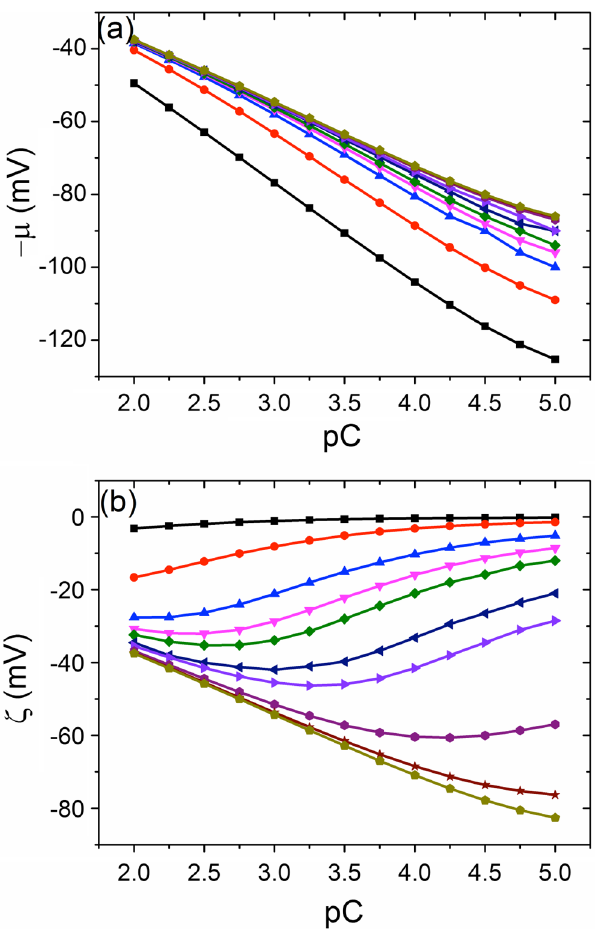
FIG. 5. (a) Chemical potential − μ plotted as a function of salt ion concentration pC under pH 9 for a set of different radii a . (b) ζ potential plotted as a function of the negative logarithm of salt ion concentration, pC, under pH 9, for a set of different radii a . In (a), the different curves represent the effect of different channel radius. From top downward, the radius are 3, 1, 0.3, 0.1, 0.07, 0.04, 0.03, 0.02, 0.008, and 0 . 002 μ m. The order is reversed in (b), with the largest radius curve at bottom. It should be noted that for a channel width of 40 nm to 300 nm, the zeta potential displays a maximum in its absolute value, just as observed